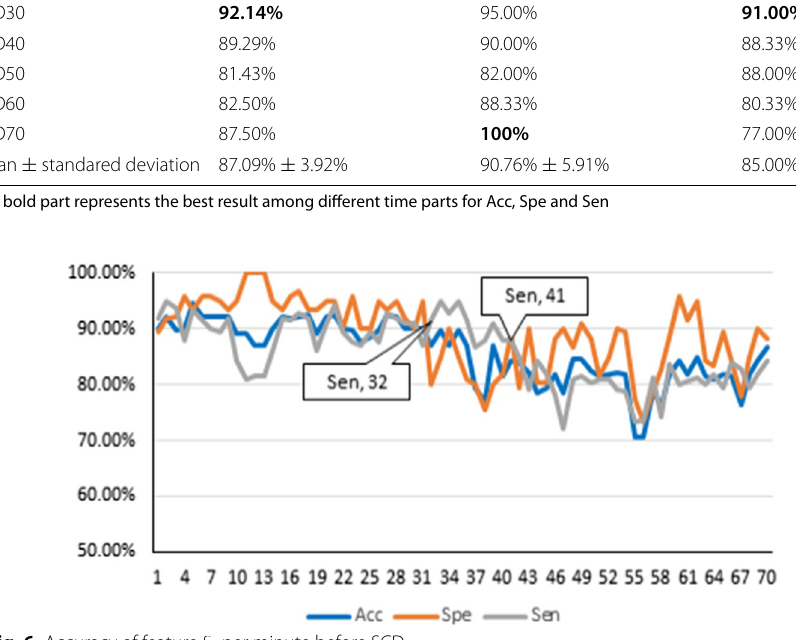
Fig. 6 Accuracy of feature S v per minute before